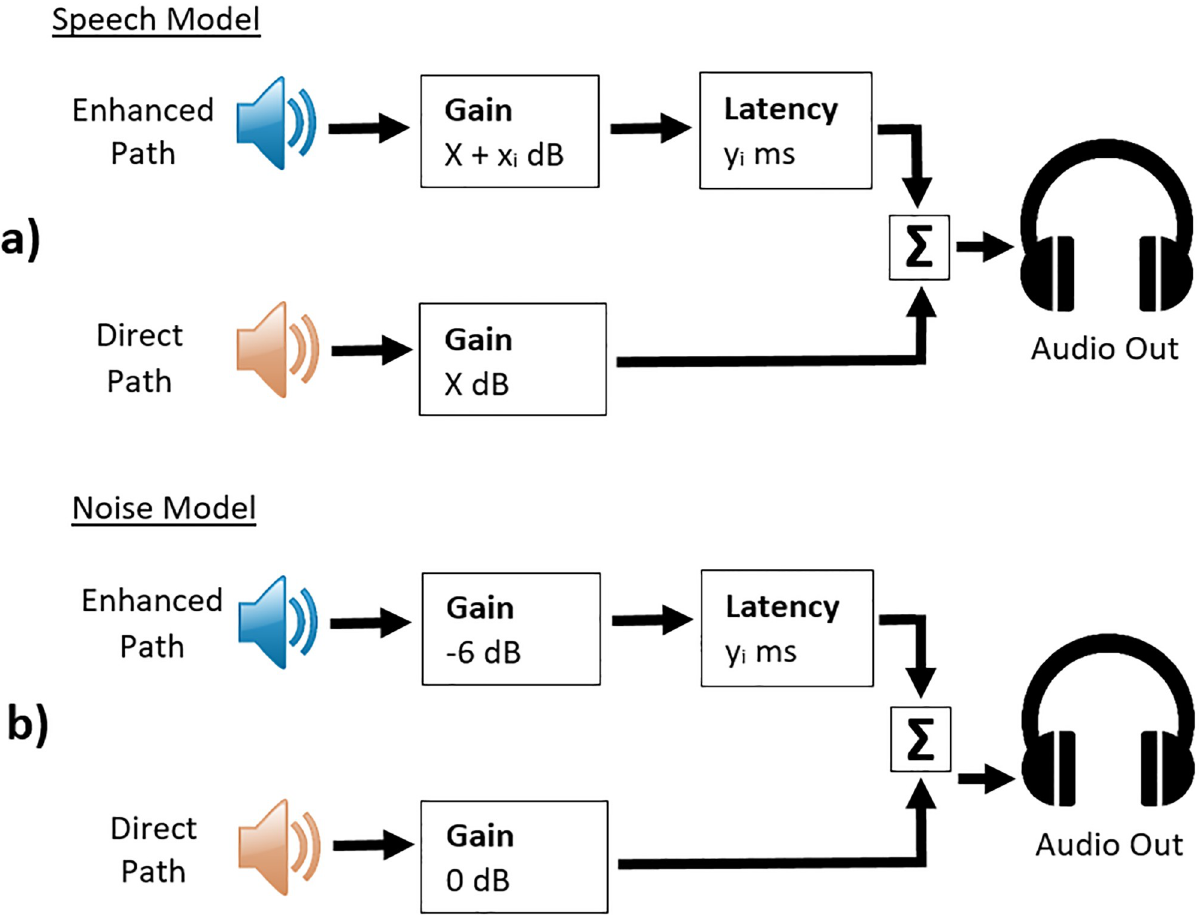
Fig 3. Simplified simulink schematic. a) Speech model containing 2 speech signals–direct path signal set at X dB and varies according to previous subject response. Enhanced path signal contains same speech signal with some additional gain of x i dB and a latency value of y i ms (i = 1,2, or 3; gain / latency pairs are described in text). b) Noise model containing 2 speech shaped noise signals–direct path fixed at 0 db, enhanced path fixed at -6 dB, representing worst case scenario of a successful beamformer, with the same latency value, y i , in speech model.